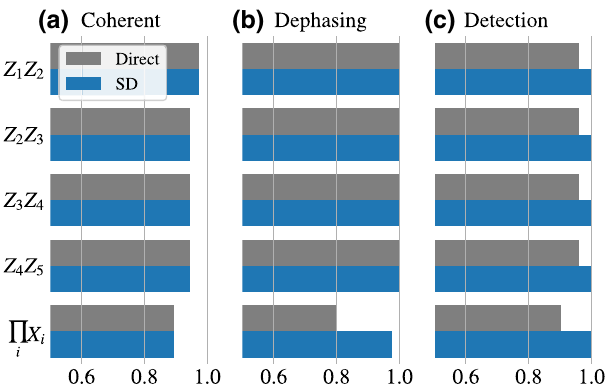
FIG. 9. Simulated effect of errors on second-order mitiga- tion. We compare the direct approach tr (ρ O ) (Direct) against the second-order mitigation (cid:3) O (cid:2) ( 2 ) (SD) for (a) coherent error with δ coh = 0.15 relative over-rotation, (b) single-qubit dephas- ing error with p deph = 0.1, and (c) detection errors with p det = 0.01.